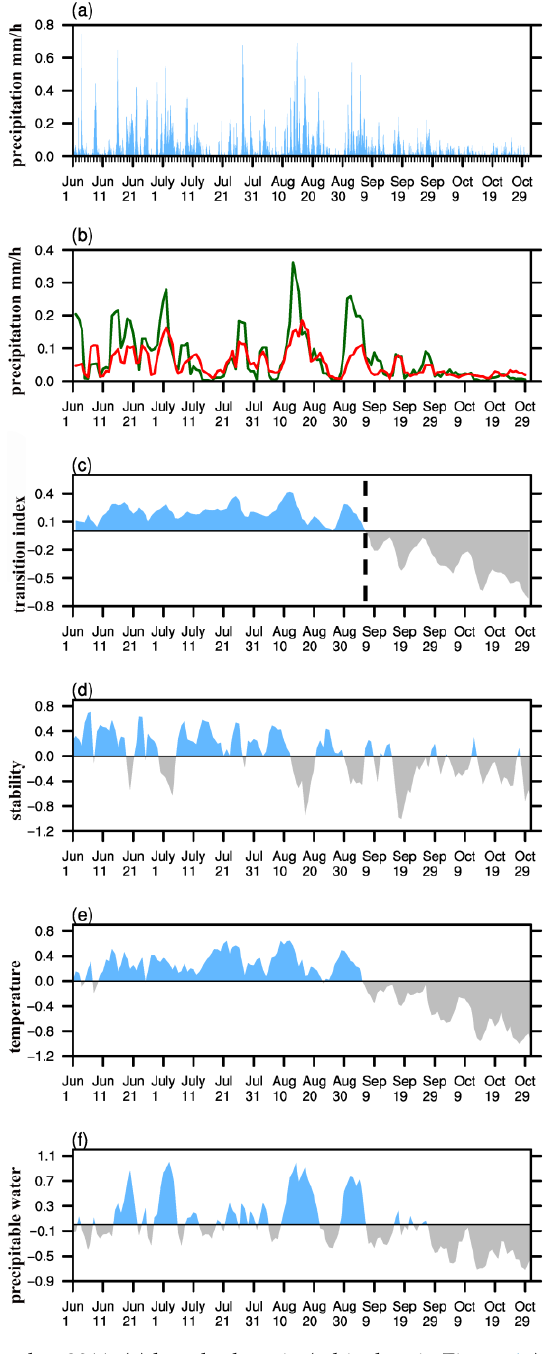
Figure A3. For June–October 2011, ( a ) hourly domain (white box in Figure 1a) averaged precipitation; ( b ) 3-day running mean of nighttime (20:00–08:00, dark green line) and daytime (08:00–20:00, red line) rainfall; ( c ) 3-day running mean of transition index anomaly (TI); normalized domain averaged ( d ) atmospheric stability anomaly, ( e ) 2 m temperature anomaly, and ( f ) precipitable water anomaly. The black dashed line in ( c ) indicates transition date 6 September 2011.